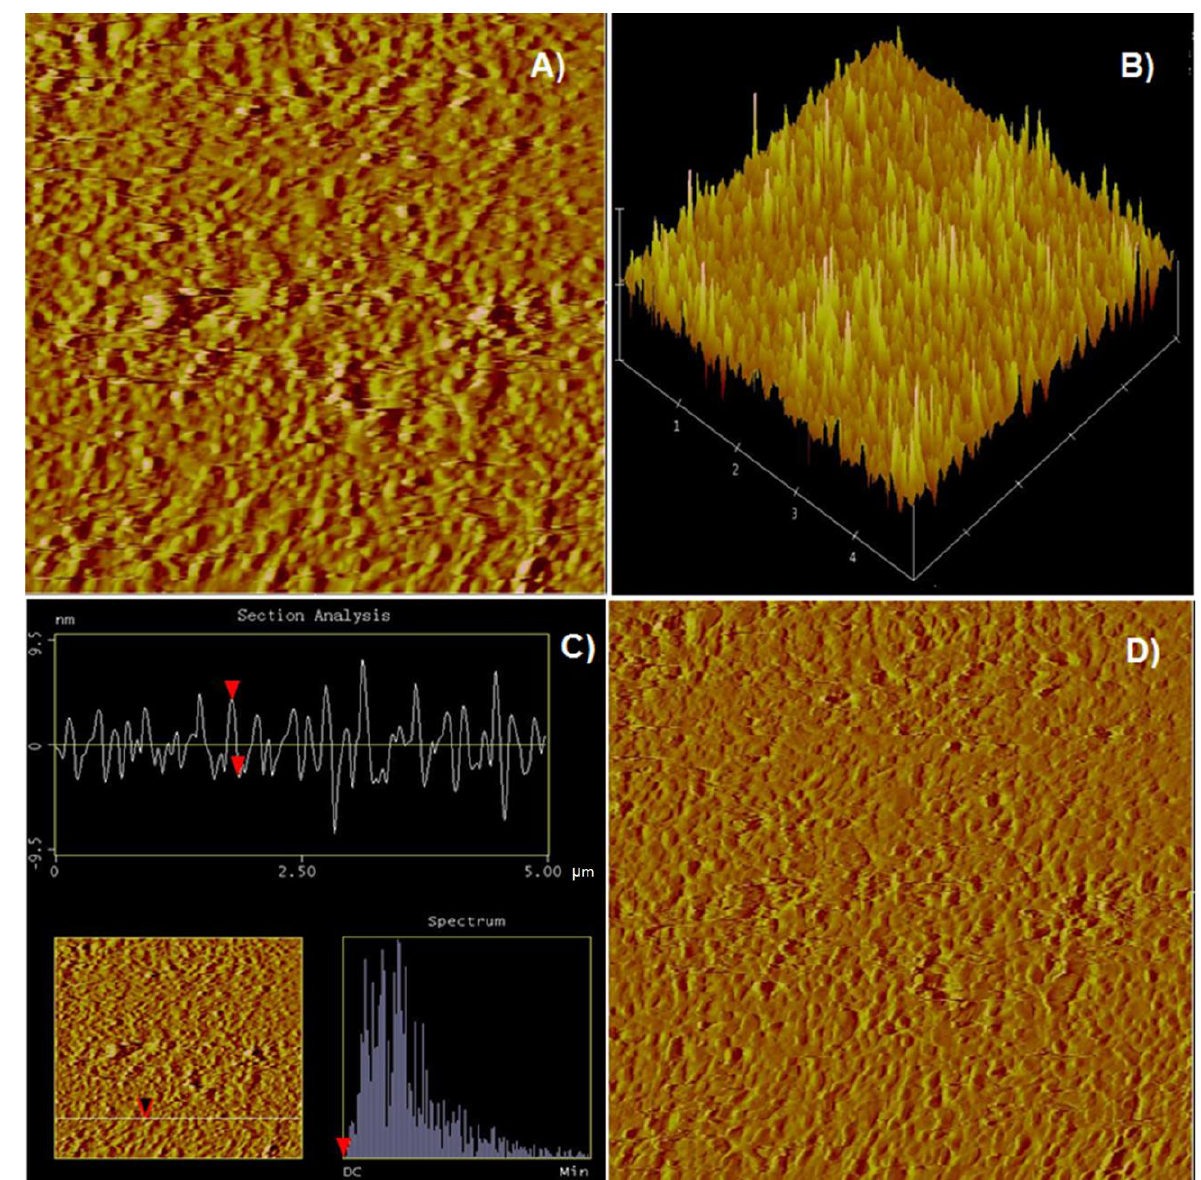
Figure 5. AFM images of a bornite surface soaked in the 1 × 10 − 4 M KEX solution at pH 6 for 20 min and further rinsed with ethanol and water. ( A ) The 5 µm × 5 µm height image with a data scale of 20 nm, ( B ) the 3D image, ( C ) the section analysis (the red arrows indicate the top and the bottom of an average asperity) and ( D ) the deflection image with a data scale of 10 nm.